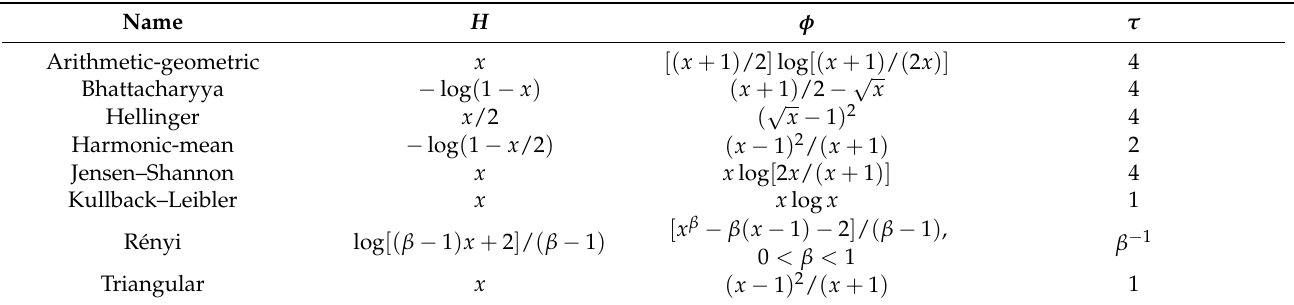
Table 1. Stochastic divergences and their H - φ